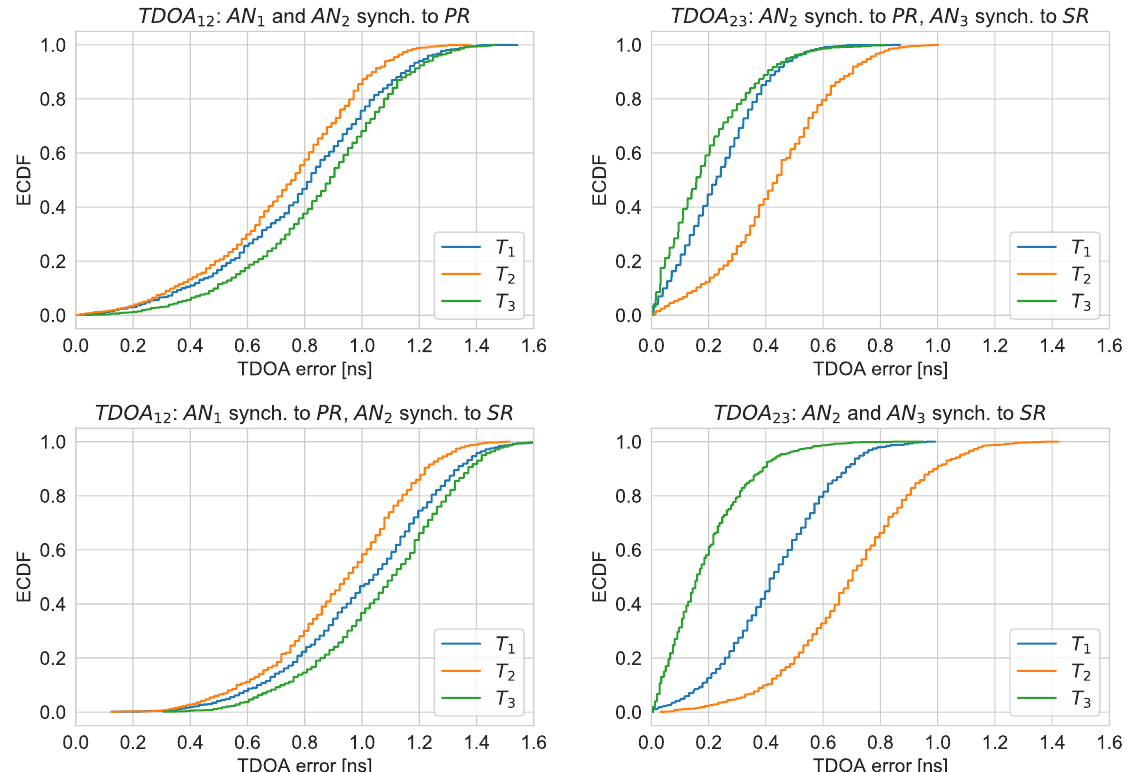
Figure 7. Empirical cumulative distribution functions of the TDOA errors for different synchronization